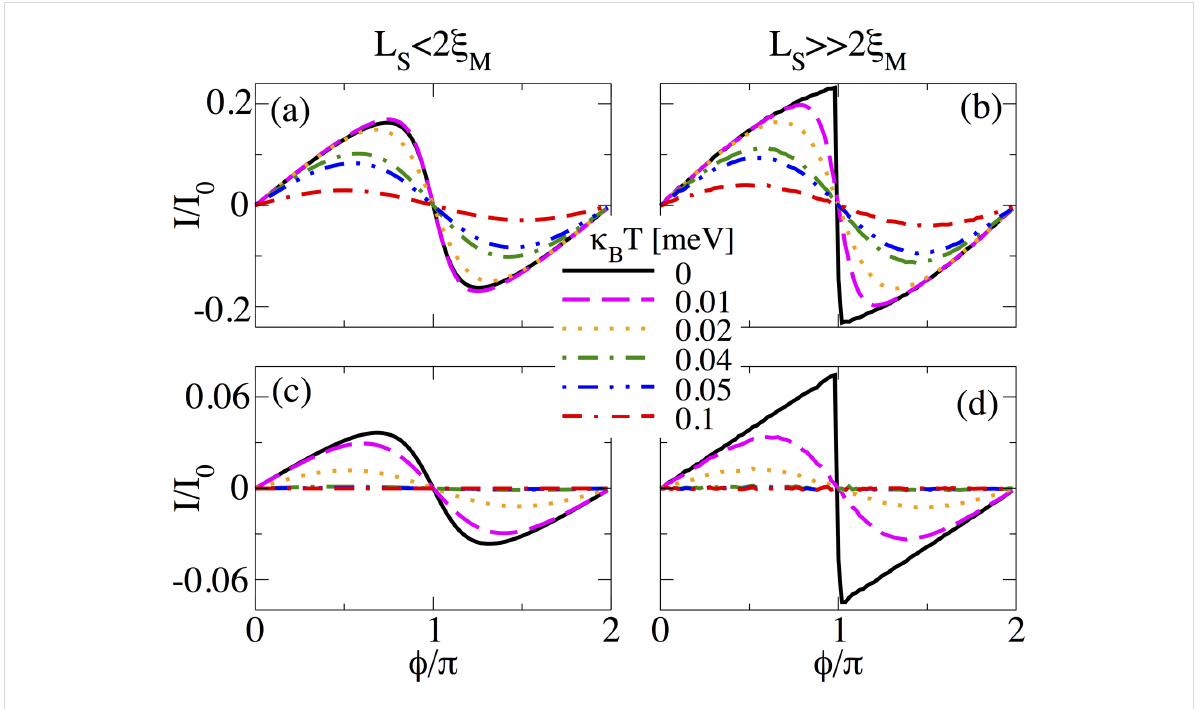
Figure 14: Finite temperature effect on the supercurrent, I ( ), in (a,b) a short and (c,d) a long junction. (a,c) L S = 2000 nm ≤ 2 ξ M and (b,d) L S = 10000 nm 2 ξ M . Different curves correspond to different values of k B T . The sawtooth profile smooths out at finite temperature. Parameters: L N = 20 nm for short and L N = 2000 nm for long junctions, α R = 20 meV·nm, μ = 0.5 meV, Δ = 0.25 meV and